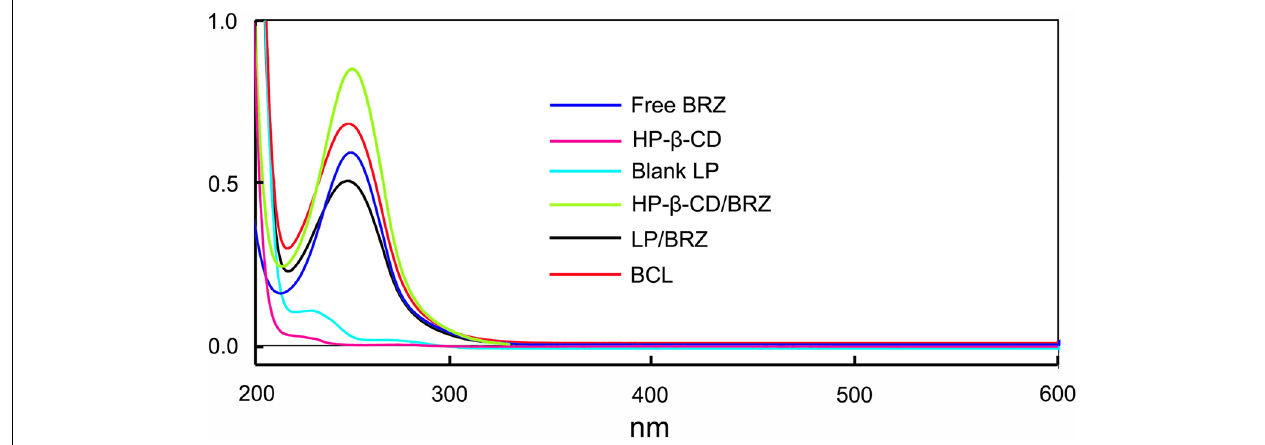
FIGURE 2 | The UV/vis spectra of free BRZ, HP- β -CD, Blank LP, HP- β -CD/BRZ inclusion complex, LP/BRZ, and BCL in acetonitrile.